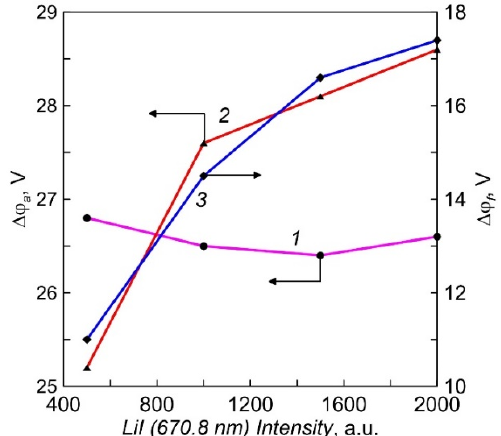
Figure 7. The dependencies of potential difference between the crucible and the plasma ( ∆ ϕ a ) and the plasma and the floating substrate( ∆ ϕ f ) on intensity of LiI line (Li vapor density). 1 , 3 —crucible with an insulated multi-aperture lid; 2 —equipotential crucible.